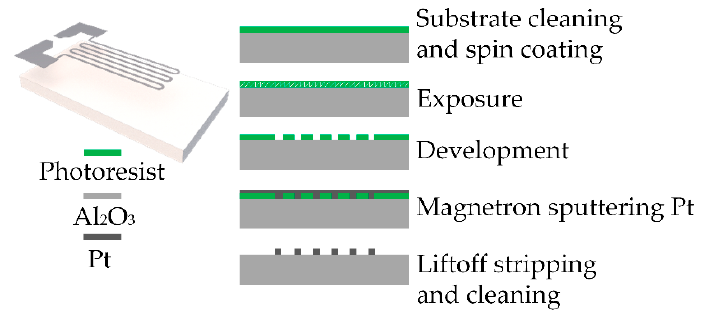
Figure 4. Process flow for the manufacturing of the heating resistor.